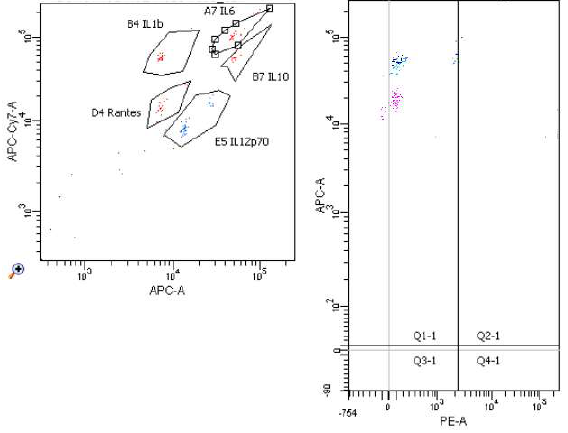
Figure 9. Il-1 β , Il-6, Il-12, Il-10 and RANTES expressions in medium (Flow Cytometry raw data for a single patient).